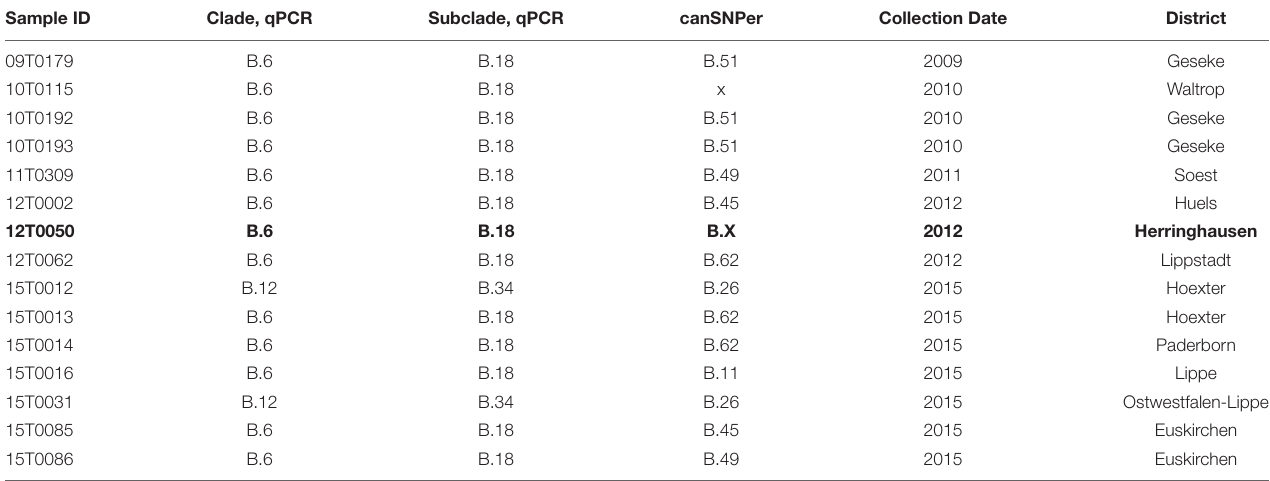
TABLE 1 | Francisella tularensis subsp. holarctica isolates from North Rhine-Westphalia (Germany) with qPCR and canSNPer results, year of collection, and district of isolation. (x; no result obtained). Sample ID Clade, qPCR Subclade, qPCR